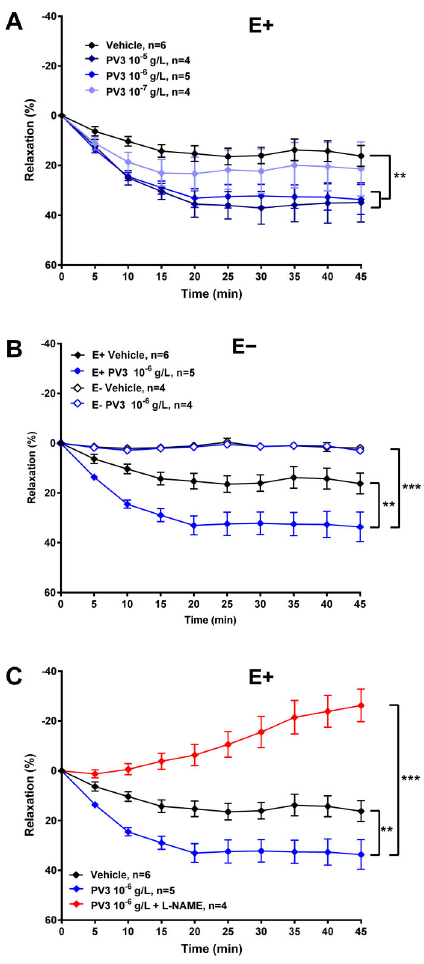
Figure 4. A , Effect of Phaseolus vulgaris peptide (PV3) (10 – 7 , 10 – 6 , or 10 – 5 g/L) on the intact endothelium (E + ) aortic rings. B , Effects of PV3 (10 – 6 g/L ) in endothelium denuded (E – ) vessels. C , PV3 (10 – 6 g/L) effects on E + vessels incubated with nitric oxide synthase (NOS) inhibitor L-NAME. The data are reported as means ±